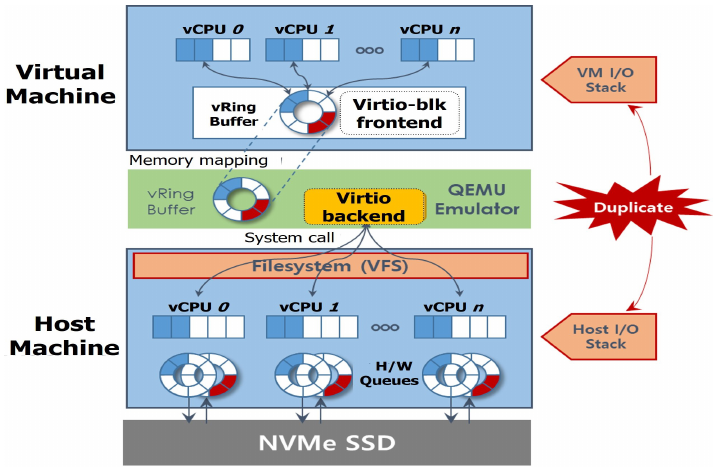
Figure 1. Virtio I/O Virtualization framework: It consists of two layers, virtual machine and host machine, which are connected via